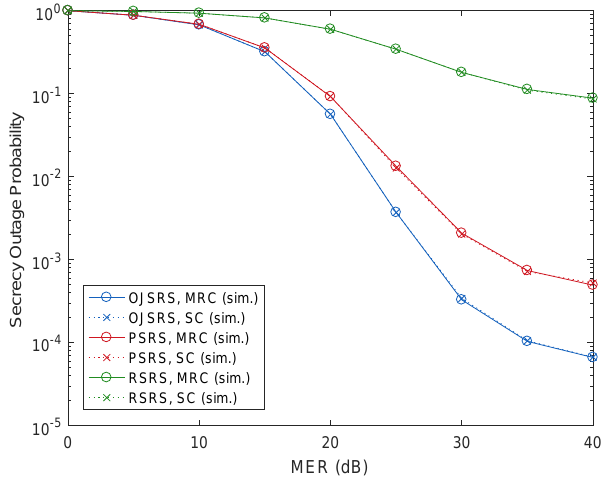
Figure 5. Performance comparison between the proposed source relay selection (PSRS), the optimal joint source relay selection (OJSRS) and the random source relay selection (RSRS) schemes with the secrecy outage probability as a function of the main-to-eavesdropper ratio (MER) with M = 3, N = 3, d SR = 0.5, SNR = 20 dB and R th = 3